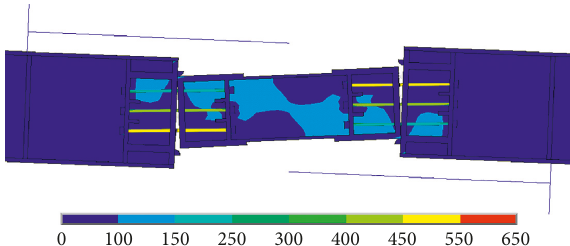
Figure 18: Deformation and stress distribution at ultimate state (unit: MPa).